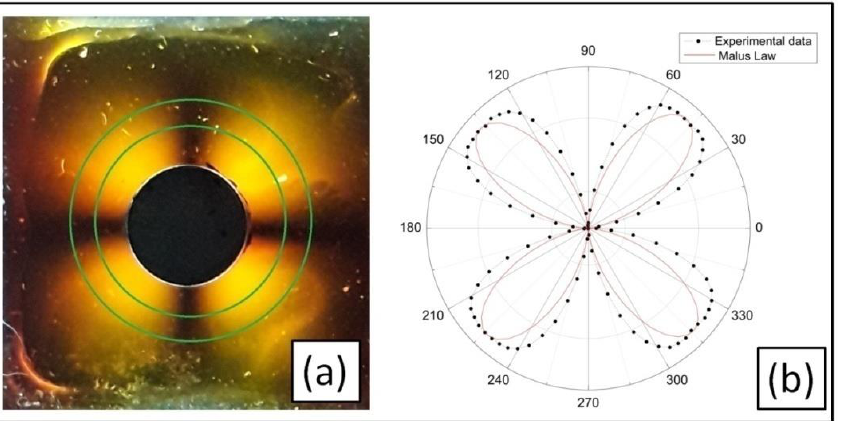
Figure 8. Checking Malus’ law using a Ferrocell. The ferrofluid sample is in the presence of a magnet with one of the poles at the center of the Ferrocell, known as a monopolar configuration. The ferrofluid is between two crossed linear polarizers. The light pattern obtained in ( a ) is in the form of four luminous lobes separated by two crossed isogyres. The region marked by the green circles is the region where the light intensity is measured for all angles. ( b ) Graph in polar coordinates comparing experimental data of light intensity (points) with Malus’ law represented by the red line.